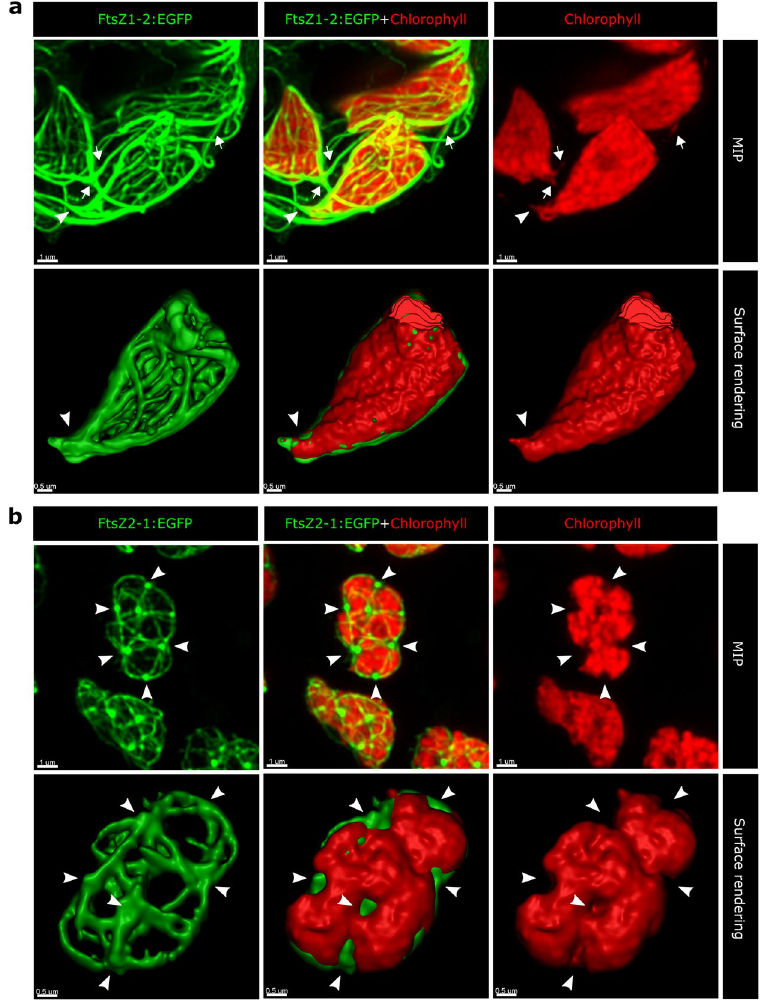
Figure 3. Morphological patterns of chloroplasts carrying FtsZ1-2::EGFP ( a ) and those carrying FtsZ2- 1::EGFP ( b ) are shown for comparison. Confocal image z-stacks were deconvolved via Huygens software (Scientific Volume Imaging). Maximum intensity projections and surface rendering were performed on selected confocal image data for each isoform by using IMARIS software (Bitplane). Surface rendering was performed by choosing a single chloroplast in the middle of the image as the object and excluding the surrounding chloroplasts and networks during segmentation. ( a ) In the presence of FtsZ1-2::EGFP networks, chloroplasts tend to adopt angular shapes, form tapered and pointed poles where dense bundles of filaments exit the chloroplasts (arrowheads). FtsZ1-2 filaments emanating from the chloroplast surface are sometimes overlapped with chlorophyll autofluorescence in the form of tubular outgrowths (arrows) implying that the growing filaments might have deformed the chloroplast surface and triggered such membrane protrusions. ( b ) Shape patterns of chloroplasts carrying FtsZ2-1::EGFP include surface indentations which occur at positions where meganodes are located (arrowheads). Surface rendering of the chlorophyll and EGFP channels shows more clearly that locations of the meganodes match the topographic indentations of the chloroplast